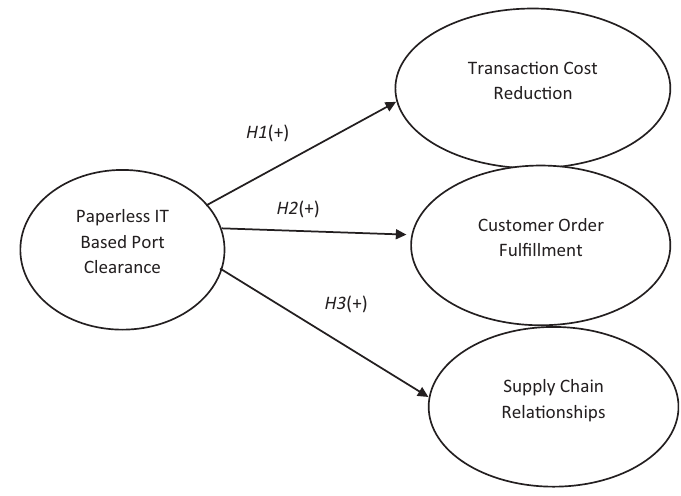
Figure 1. Conceptual